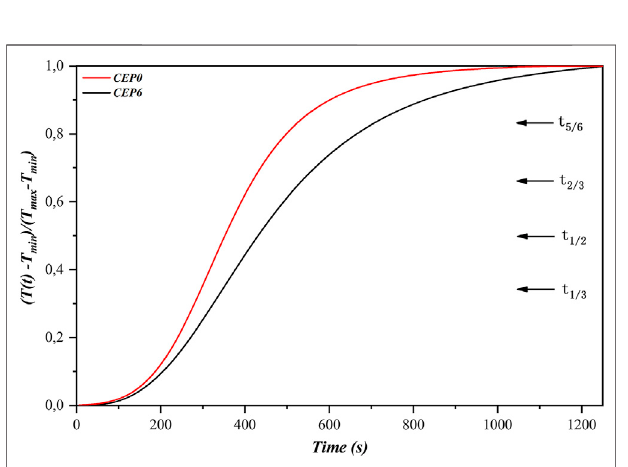
FIGURE7| ThermographcomparisonbetweenCEP6andthereference composites.